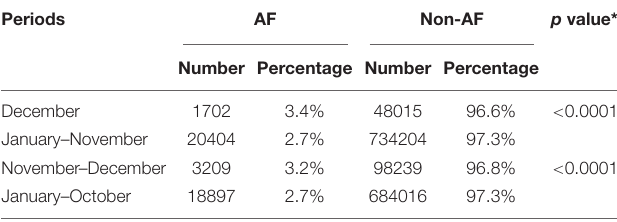
TABLE 2 | Comparisons of AF prevalence between different periods in